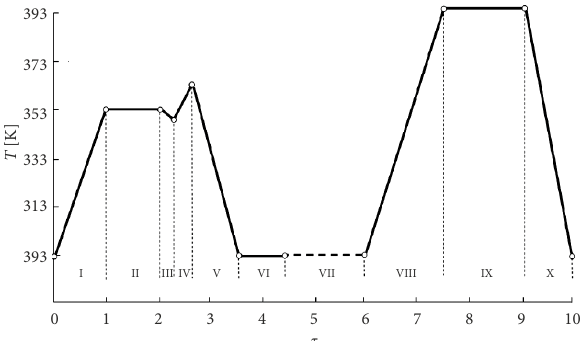
Figure 13. Diagram of temperature-time conditions for the for- mation of a